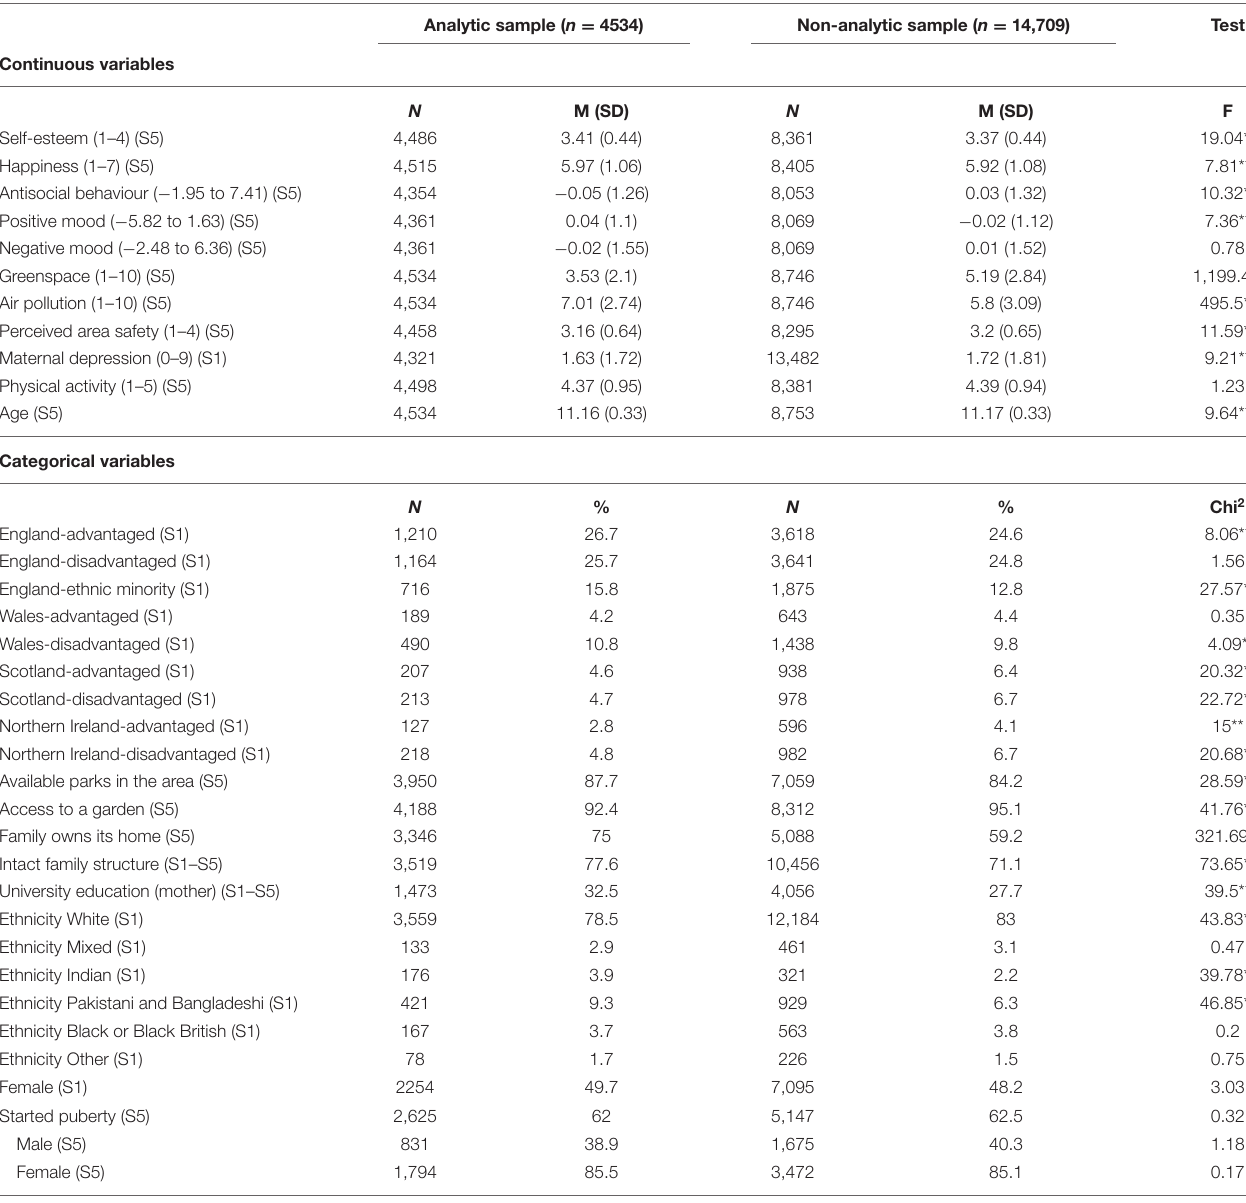
TABLE 1 | Bias analysis of study variables between analytic and non-analytic samples. Analytic sample ( n = 4534) Non-analytic sample ( n = 14,709)